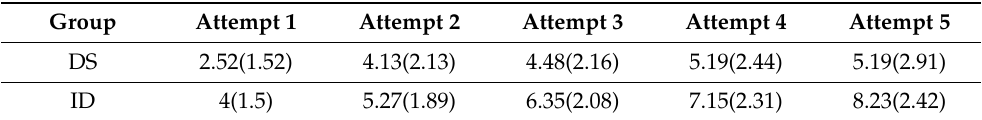
Table 6. Word List Learning Performance (mean total correct, with SD in parentheses) on Individual